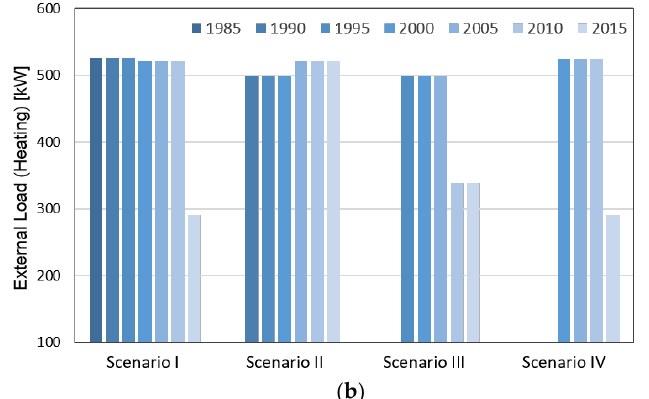
Figure 7. ( a ) is changes in the load of external per scenario in cooling period, while ( b ) is the result in heating period.